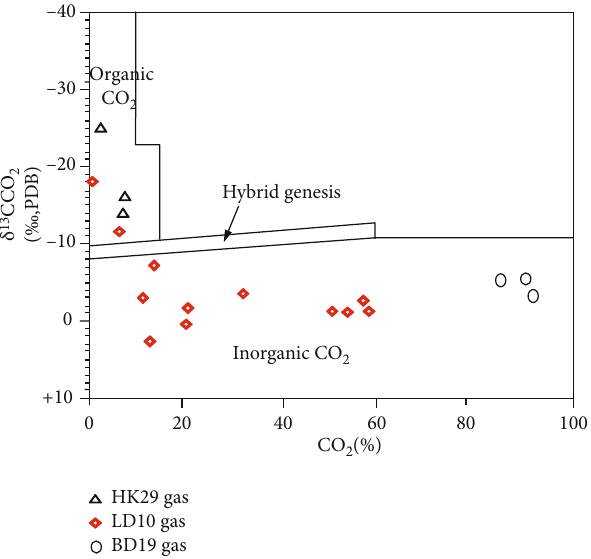
Figure 4: Classi fi cation of CO